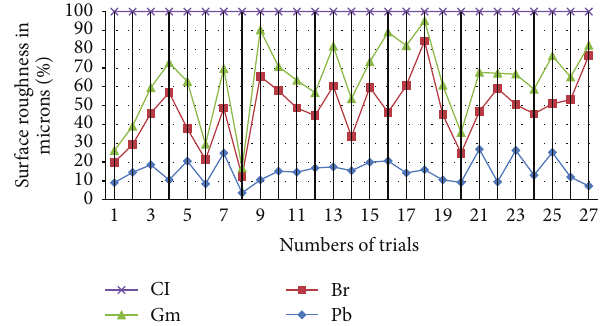
Figure 4: Comparison percentile graph (taking highest as 100%) for surface roughness variation of brittle